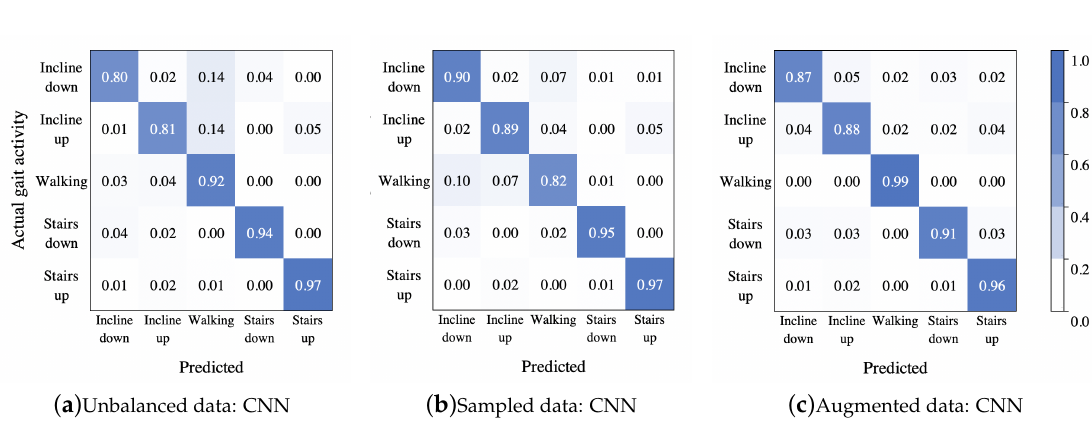
Figure 11. Confusion matrices showing the CNN model classification performance after being training by a unbalanced data, sampled data and augmented data.